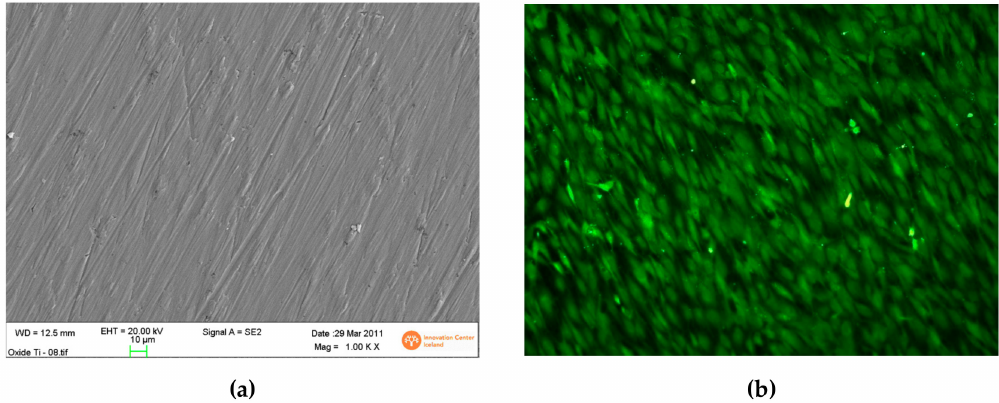
Figure 11. The chitosan coatings with osteoblasts after applying the reagents, carboxyfluorescein succinimidyl ester (CFSE; the green images or “a”) and 4 (cid:48) ,6-Ddiamidino-2-phenylindole (DAPI; the blue images or “b”): ( a ) DD 87% sigma, ( b ) DD 87%, ( c ) DD 94%, and ( d ) oxidized titanium. Magnification 25 × .